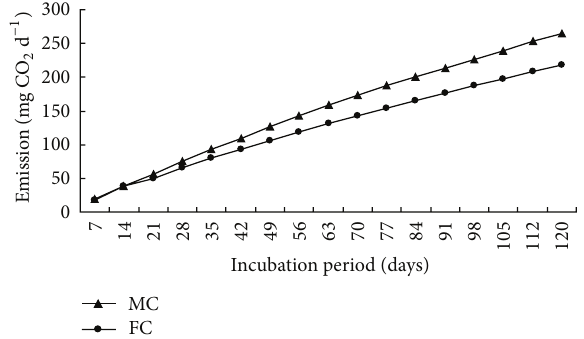
Figure 4: Cumulative CO 2 -C evolution at different water levels.